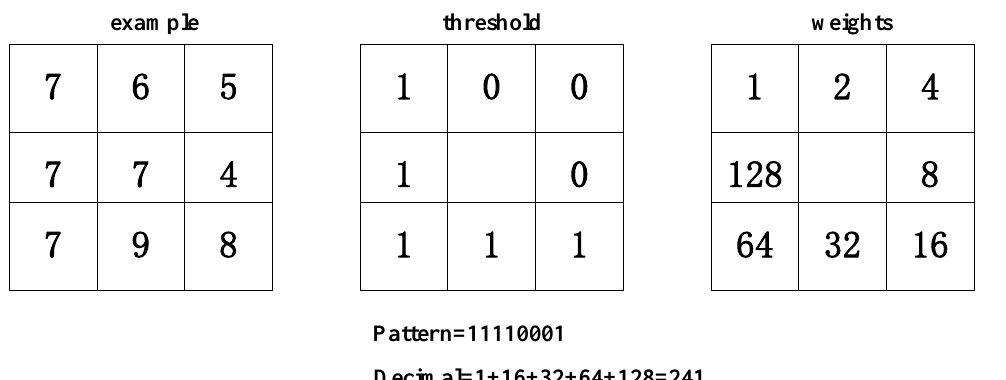
Figure 1. An illustration of the basic local binary patterns (LBP)